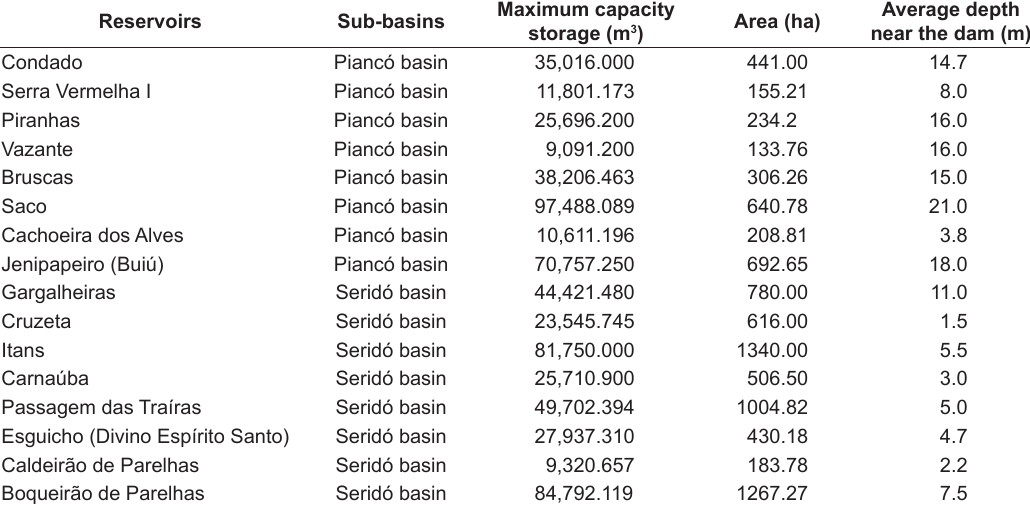
Table 1. Morphometric variables for the 16 reservoirs included in the